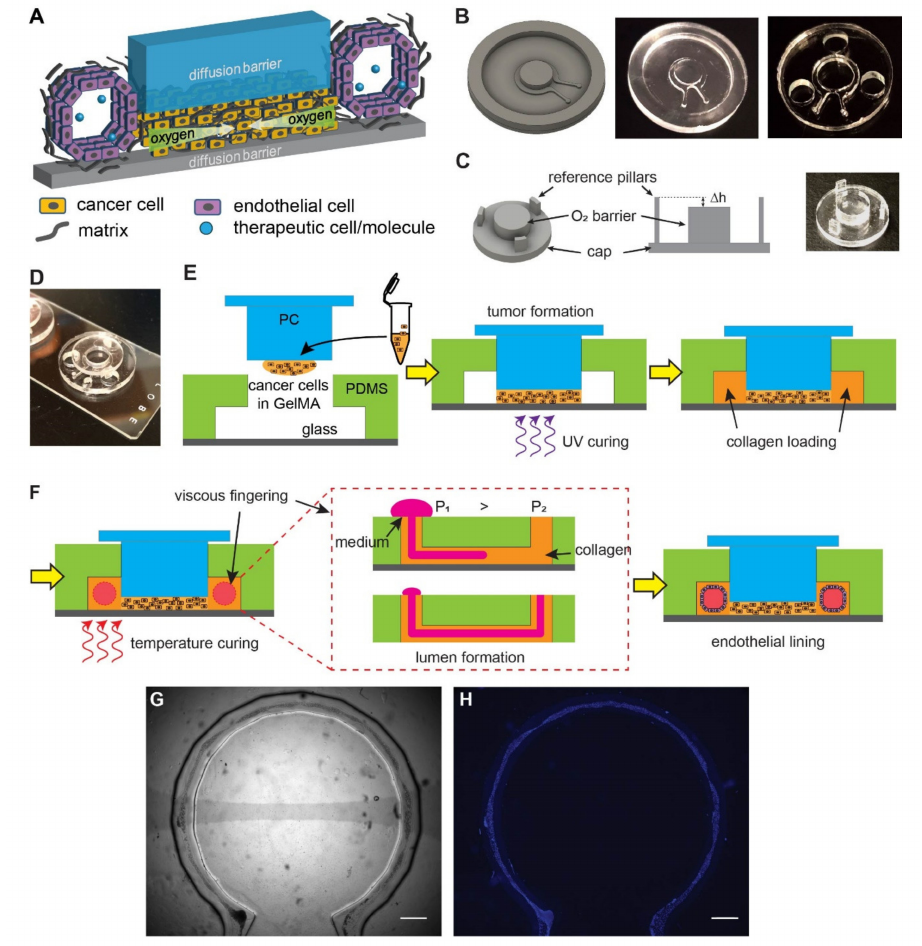
Figure 1. Design and fabrication of the vascularized hypoxic tumor model. ( A ) Schematics of hypoxia device with surrounding vasculature. ( B ) Design of the microfluidic mold, the milled polycarbonate (PC) product, and the replica molded PDMS device (with punched holes for the reference pillars). ( C ) Design of the oxygen barrier cap, the role of reference pillars in determining the gap size ( ∆ h), and the milled PC cap. The ∆ h determines the thickness of tumor section in the model. ( D ) An assembled device on a glass slide. ( E ) The assembly of the tumor model prior to vascular formation. ( F ) Formation of vasculature by viscous fingering and endothelial lining. ( G ) A completed device with endothelial lining in bright field. ( H ) Fluorescent nuclear staining of the endothelial lining (blue) for the device in ( G ). Scale bars: 1